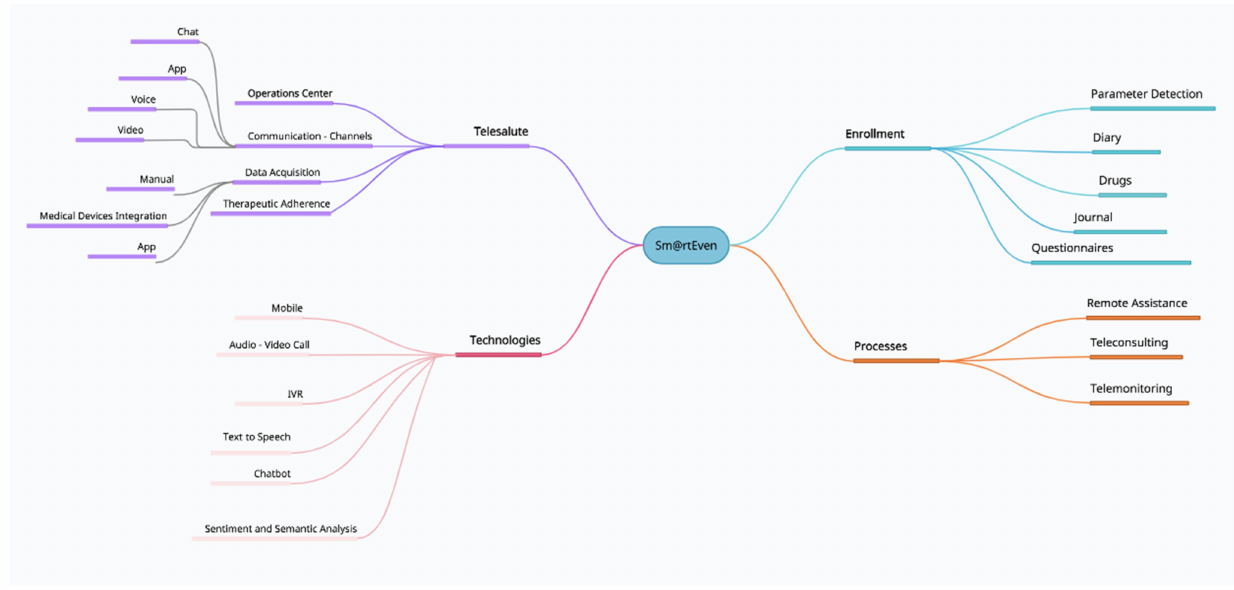
Figure 1. The different components involved in the functions of the Smart@Even application have been graphically represented. (IVR: interactive voice